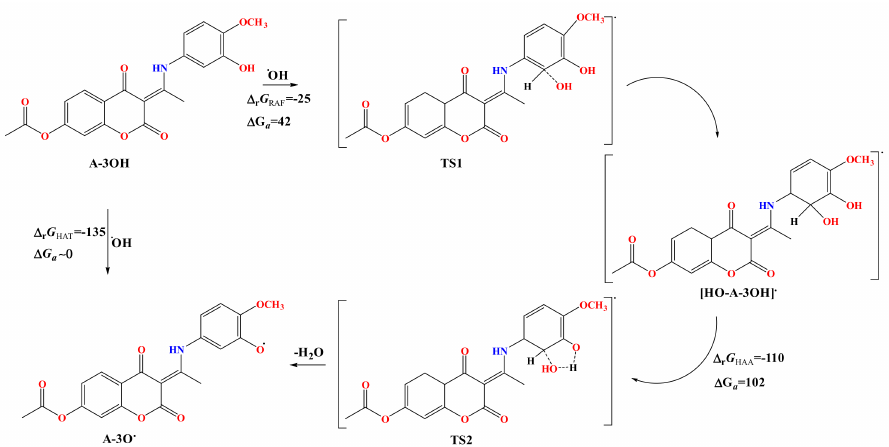
Scheme 2. Mechanisms of radical adduct formation (RAF) and intramolecular separation of a water molecule ( i HAA) at C2 ” position of A-3OH